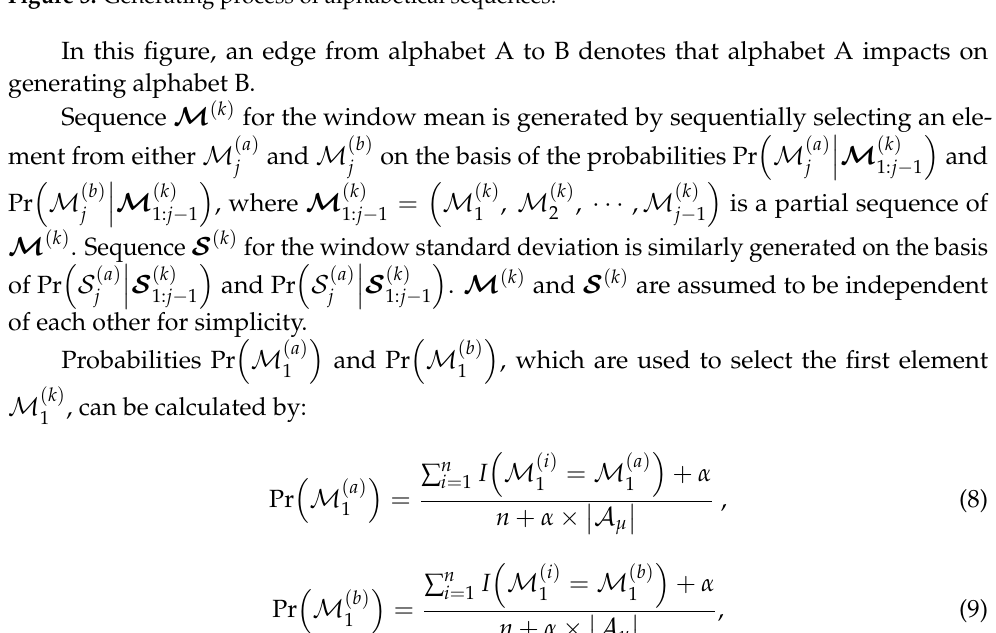
Figure 3. Generating process of alphabetical sequences.